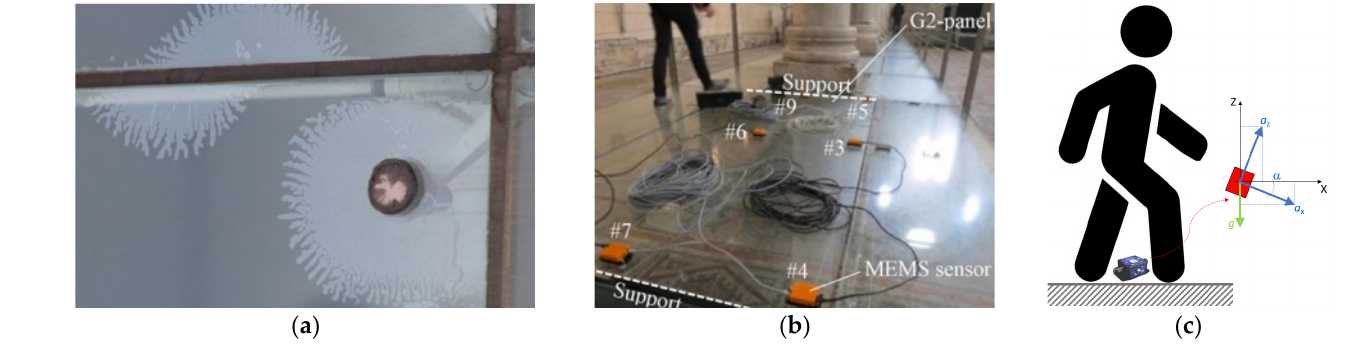
Figure 4. Application of Operational Modal Analysis to in-service LG pedestrian systems: ( a ) exam- ple of delamination in LG (figure reproduced from [36] under the terms and conditions of CC-BY license agreement); ( b ) overview of past experimental study with multiple MEMS sensors (figure reproduced from [19] under the terms and conditions of CC-BY license agreement); and ( c ) schematic representation of in- fi eld assessment based on single MEMS setup.